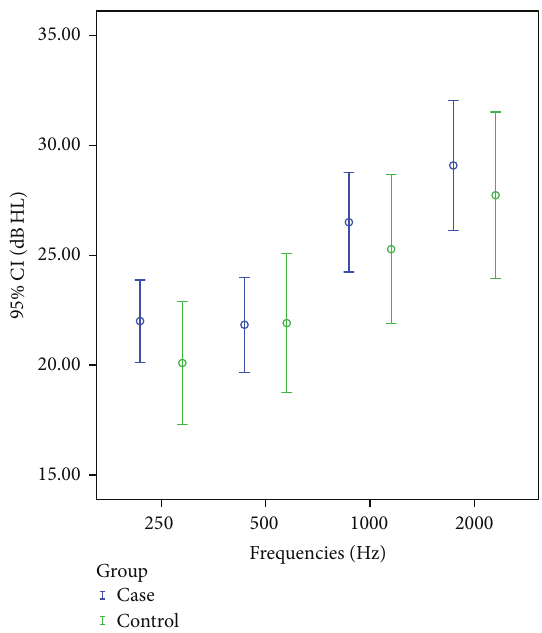
Figure 2: Right ear mean hearing threshold levels (95% confidence interval (CI), decibels (dB), and hearing level (HL) in 4 frequencies in Hz in case and control